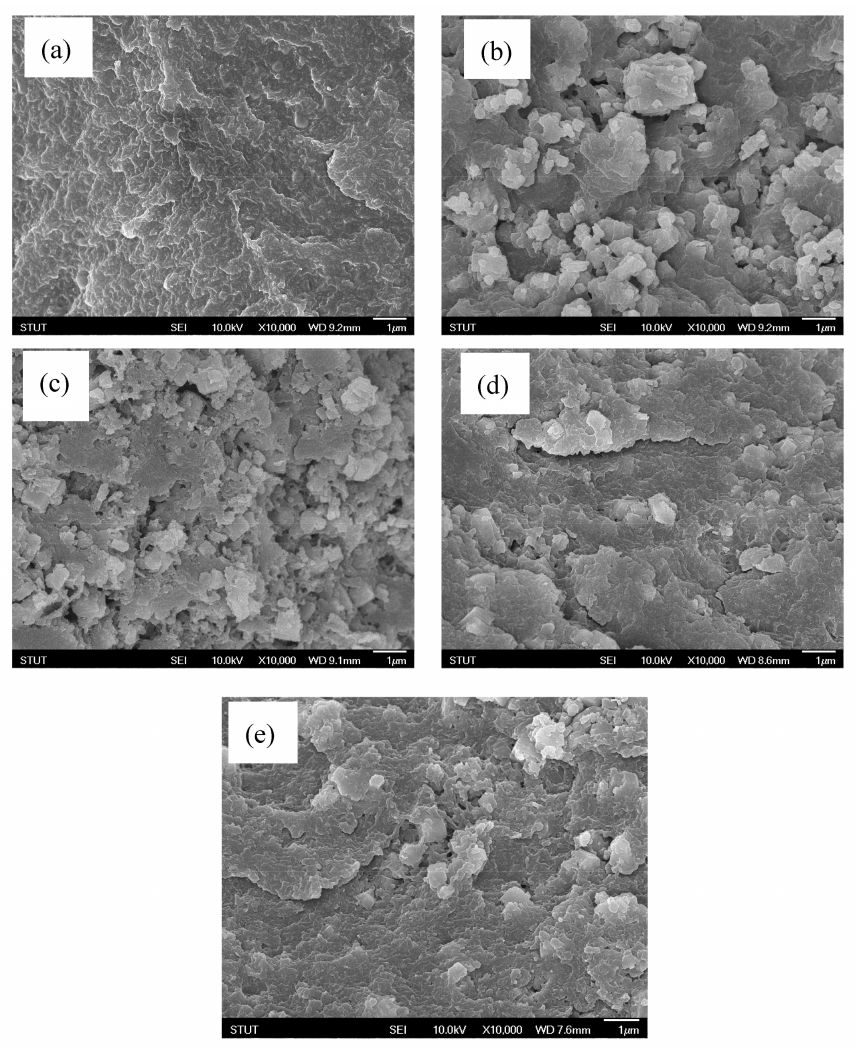
Figure 5. FE-SEM images of ( a ) pure PANDB and PANDB/ χ -Al 2 O 3 composites synthesized at